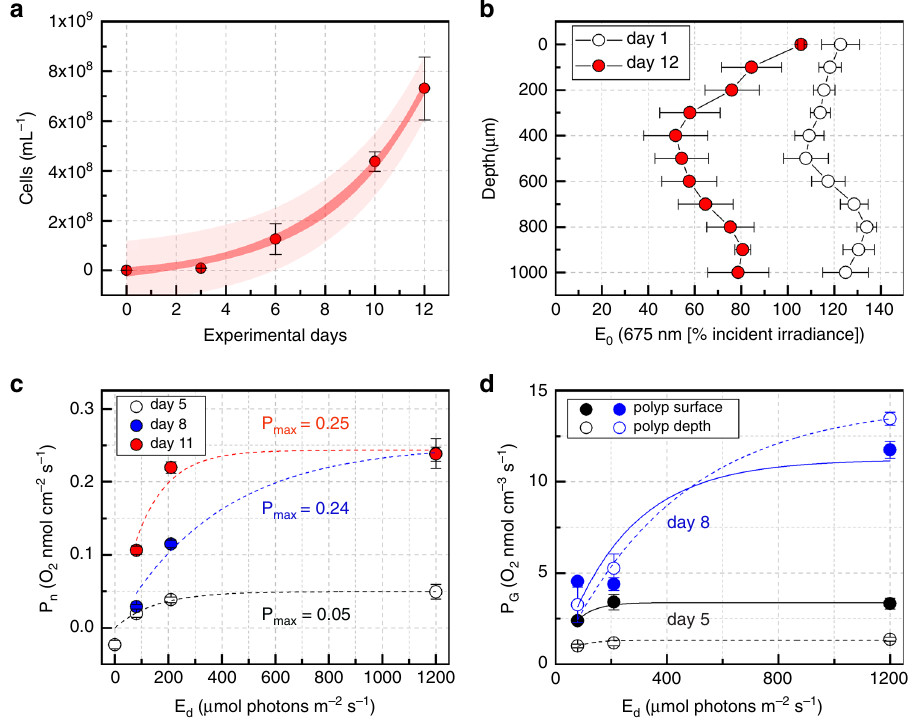
Fig. 3 Performance testing of 3D printed bionic coral. Growth of Marinichlorella kaistiae KAS603 in bionic coral ( a ). Data are means ( ± SEM, n = 3-6 bionic coral prints). Dark and bright red areas show 95% con fi dence and prediction intervals, respectively. Vertical attenuation of fl uence rate (E 0 at 675 nm) at the beginning (day 1, means ± SEM, n = 4) and end of the performance test (day 12, means ± SEM, n = 3) ( b ). Net photosynthetic rates at day 5, 8, and 11 (means ± SEM, n = 3 – 10 corallites) ( c ). Lines represent curve fi ts (see Methods). Gross photosynthetic rates at day 5 (black) and day 8 (blue) ( d ). Symbols are means (±SEM, n = 2 – 6 corallites), lines are curve fi ts. Measurements were performed with O 2 microsensors at the center of the corallite cup surface (closed symbols/solid lines) and at a vertical depth of 300 µ m (open symbols/dashed